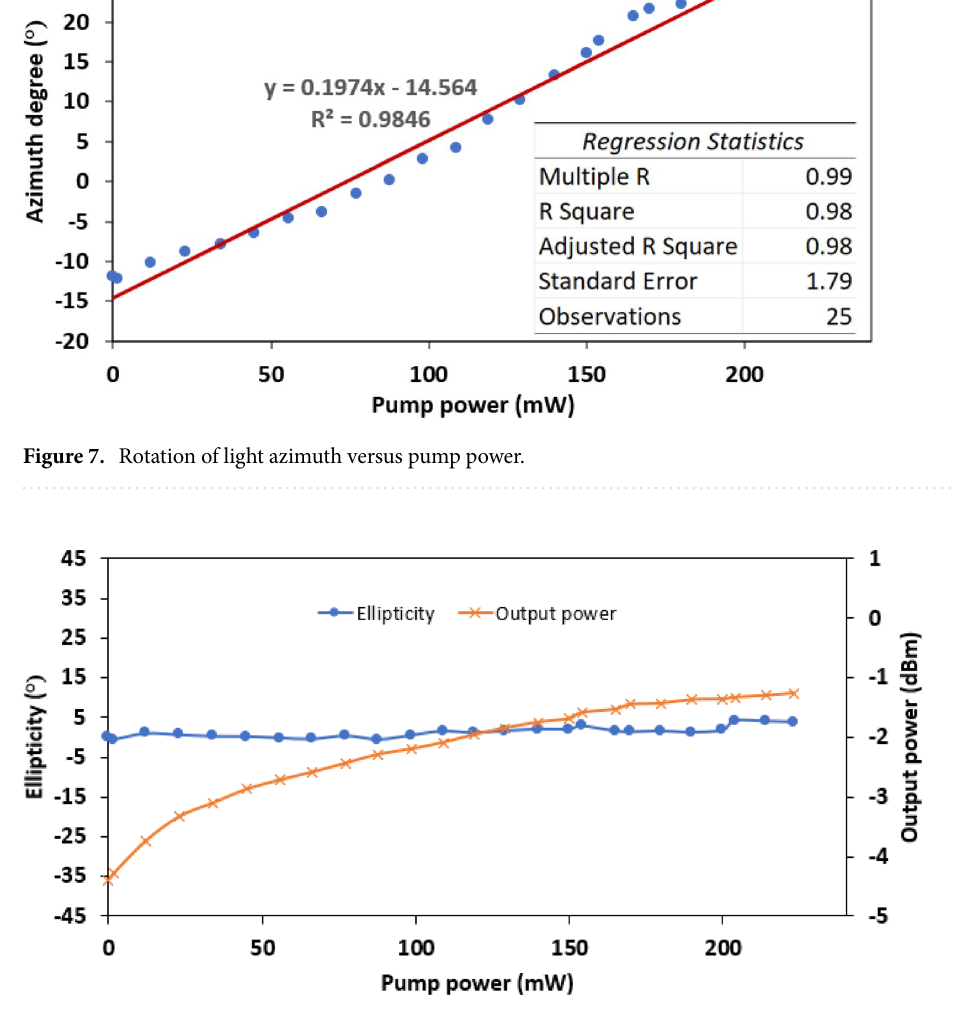
Figure 8. Light ellipticity and output power versus pump power.